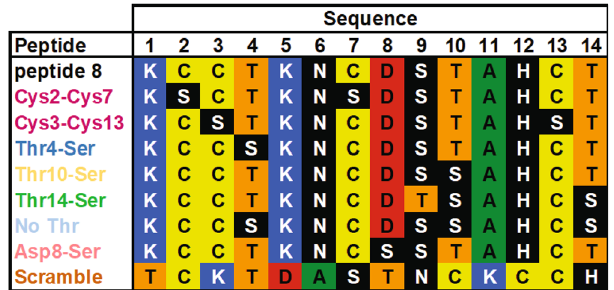
Fig. 7 Peptides studied for ice recrystallization inhibition activity. Listed are the sequence of peptide 8 as well as of the mutants of peptide 8 , which were investigated to establish structure-activity